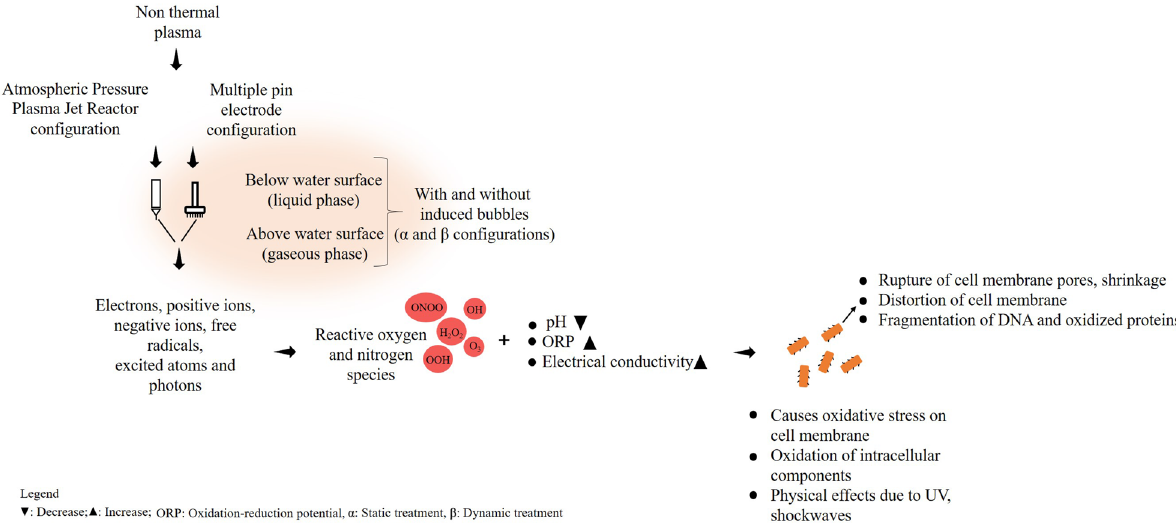
Figure 1. Basic schematic diagram representing the degradation mechanisms occurring due to